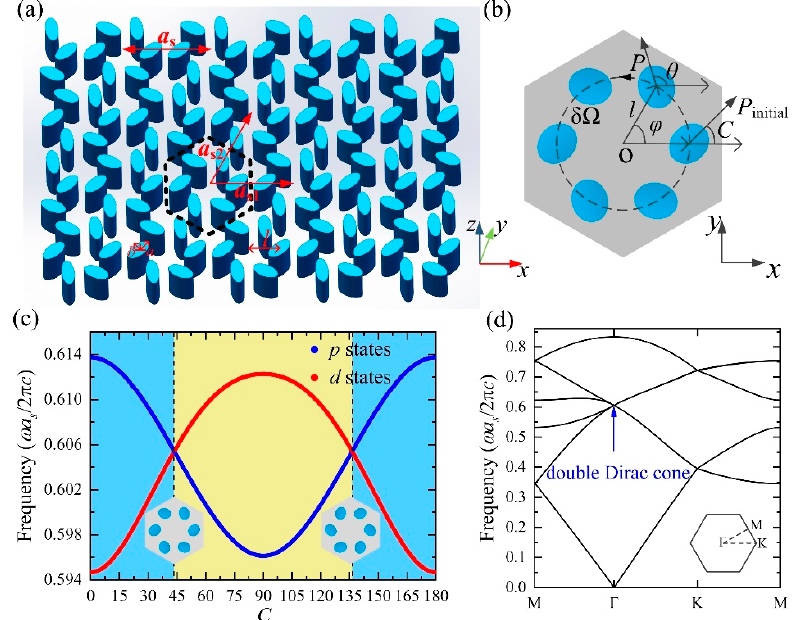
Figure 1. ( a ) Schematic of triangular-lattice photonic crystals (PCs), consisting of six elliptical alumina cylinders (blue) embedded in air background (gray). ( b ) Top-view unit cell and θ -space of the PCs. ( c ) Calculated eigenfrequencies of the two two-fold degenerated states at the Γ point, in dependence to the initial phase C . Unit cells of the topological transition points are indicated in the inset. The band inversion e ff ect and multiple topological transitions was clearly observed. The cyan (yellow) regions represent the nontrivial (trivial) regimes. ( d ) Dispersion relations of the structures in which C = 43.5 ◦ and 136.5 ◦ . A double Dirac cone with a four-fold accidental degeneracy is seen at the Γ point. Inset: First Brillouin zone of triangular